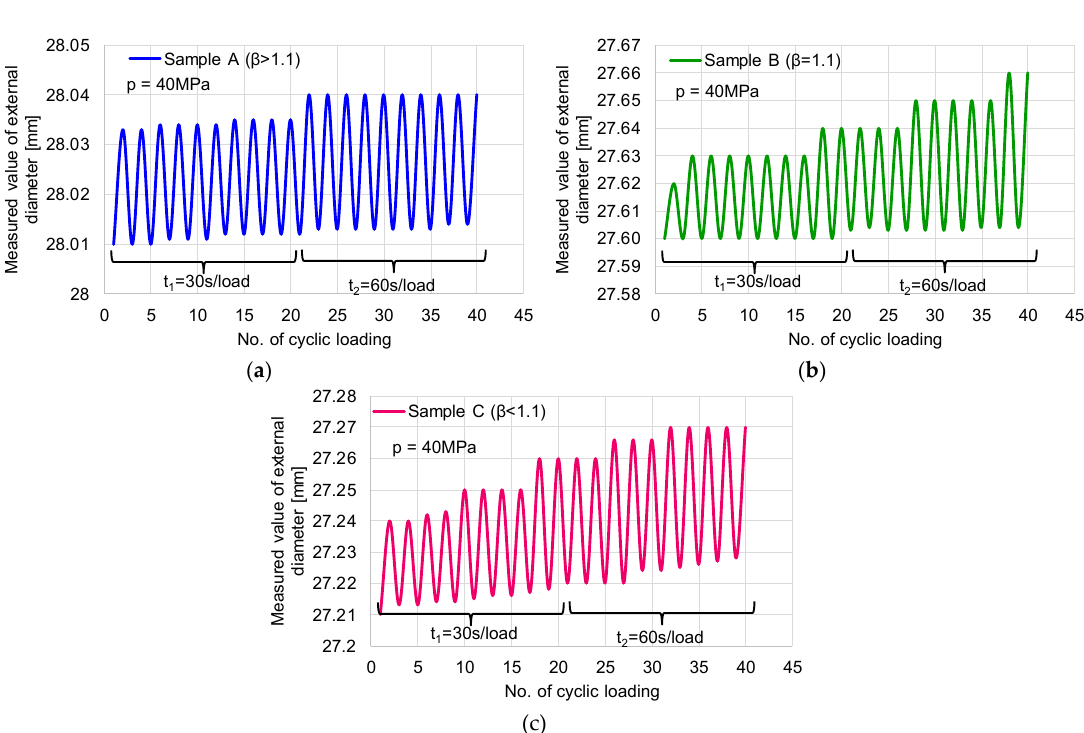
Figure 11. Cyclic variation of exterior diameters of tested samples: ( a ) Sample A; ( b ) sample B; ( c ) sample C.